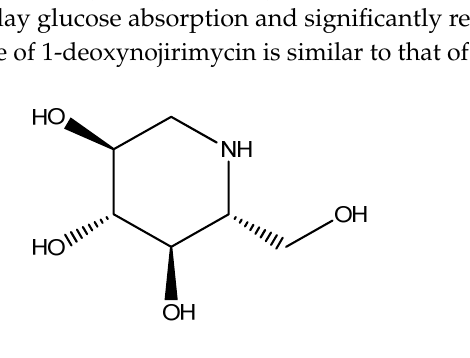
Figure 1. The chemical structure of DNJ.